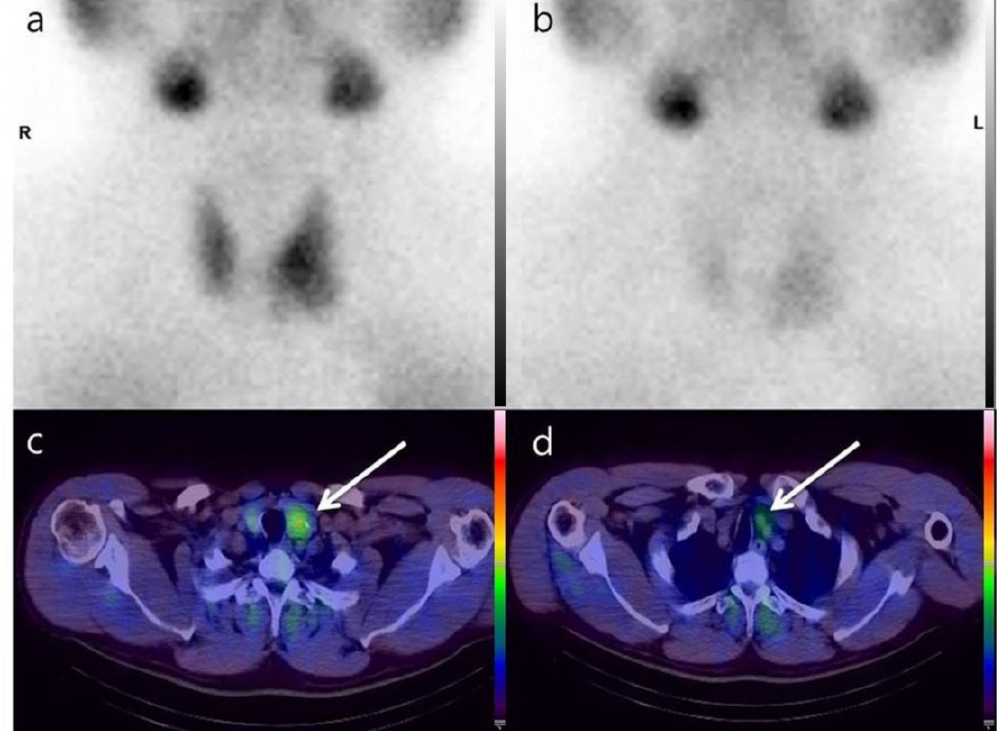
Figure 2. Parathyroid lesions detected by Tc-99m MIBI single photon-emission computed tomography / computed tomography. Two lesions (white arrows) with focal radioactive uptake were detected in the left thyroid lobe ( c , d ). These lesions were not detected by early ( a ) or delayed ( b ) Tc-99m MIBI planar scintigraphy images. R: right; L: